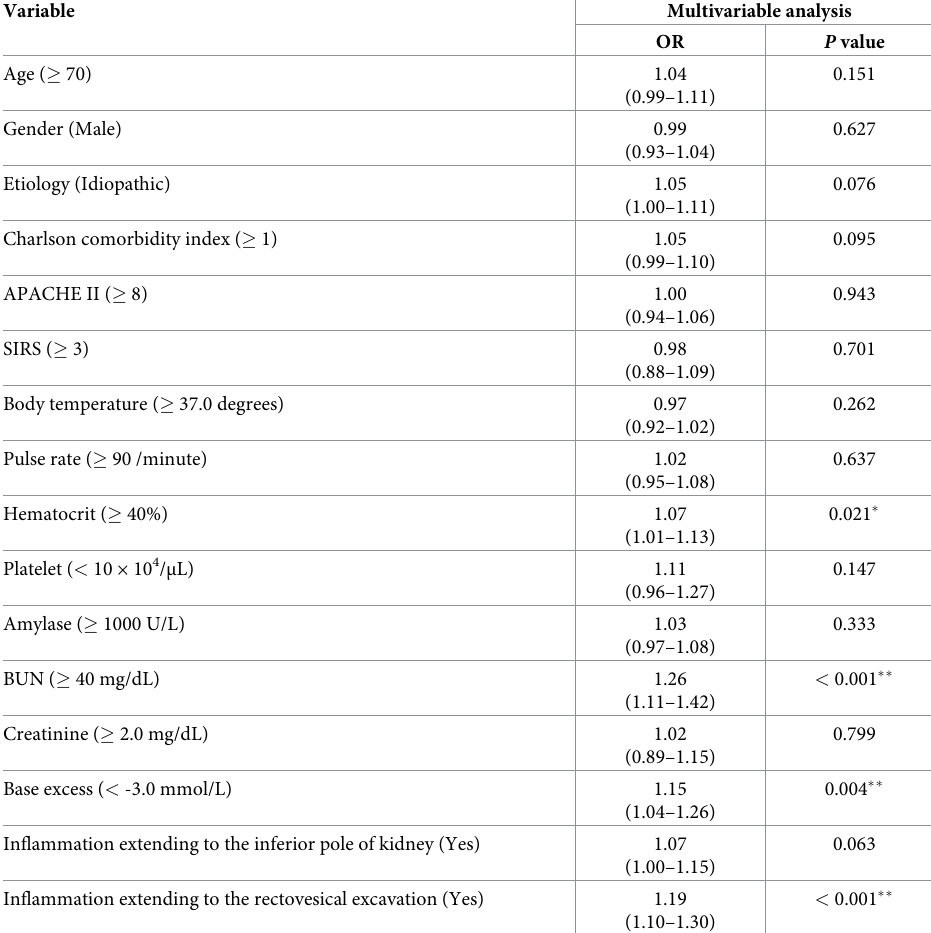
Table 4. Predictors of mortality on admission